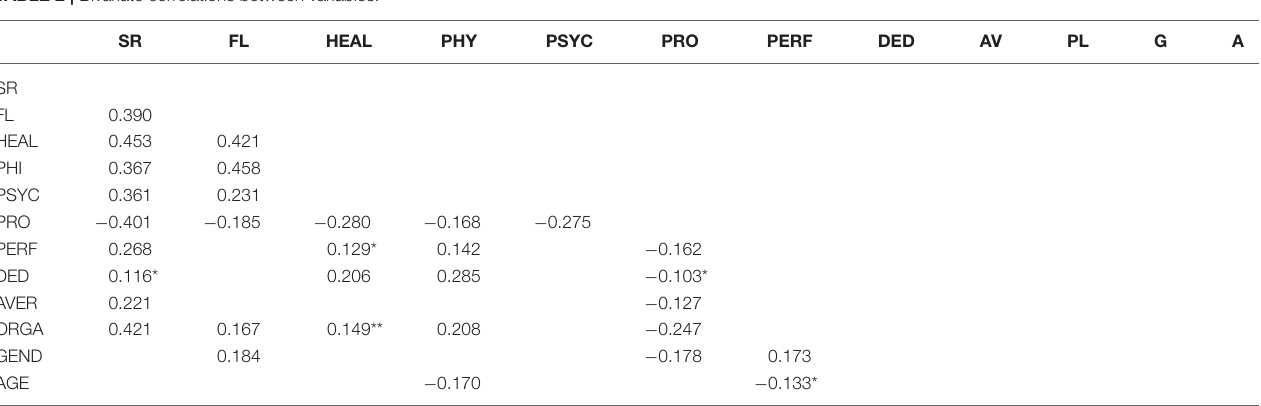
TABLE 2 | Bivariate correlations between